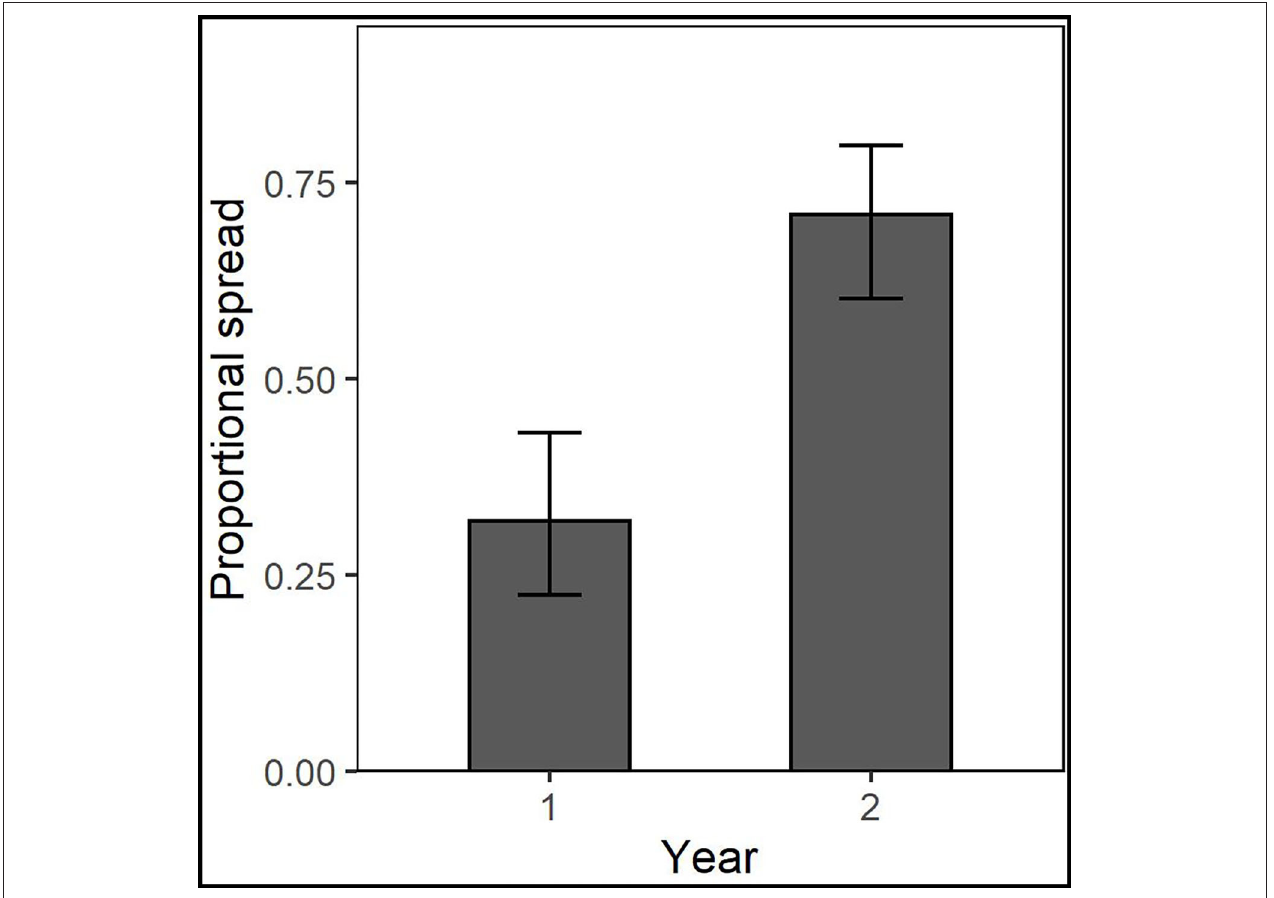
FIGURE 4 | Common OTUs identified across years within the Chanute site were more likely to spread from the nurse plant row in the second